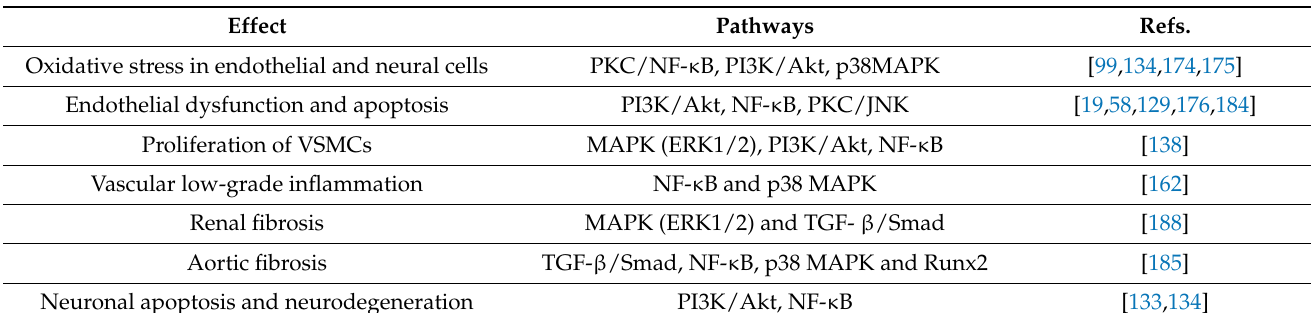
Table 1. The principal signaling pathways mediating the pathophysiological effects of high GV in diabetic complications.